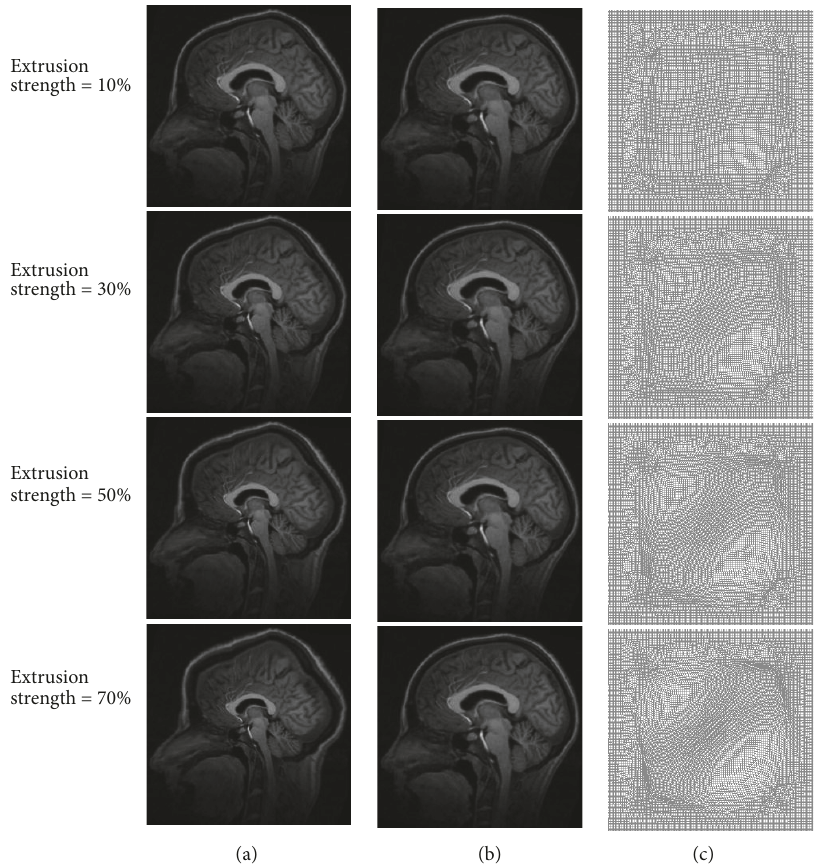
Figure 9: Medical image registration with large deformation produced by extrusion. (a) Moving images produced for extrusion strengths of 10%–70%, (b) corresponding registration results, and (c) corresponding final deformation fields.